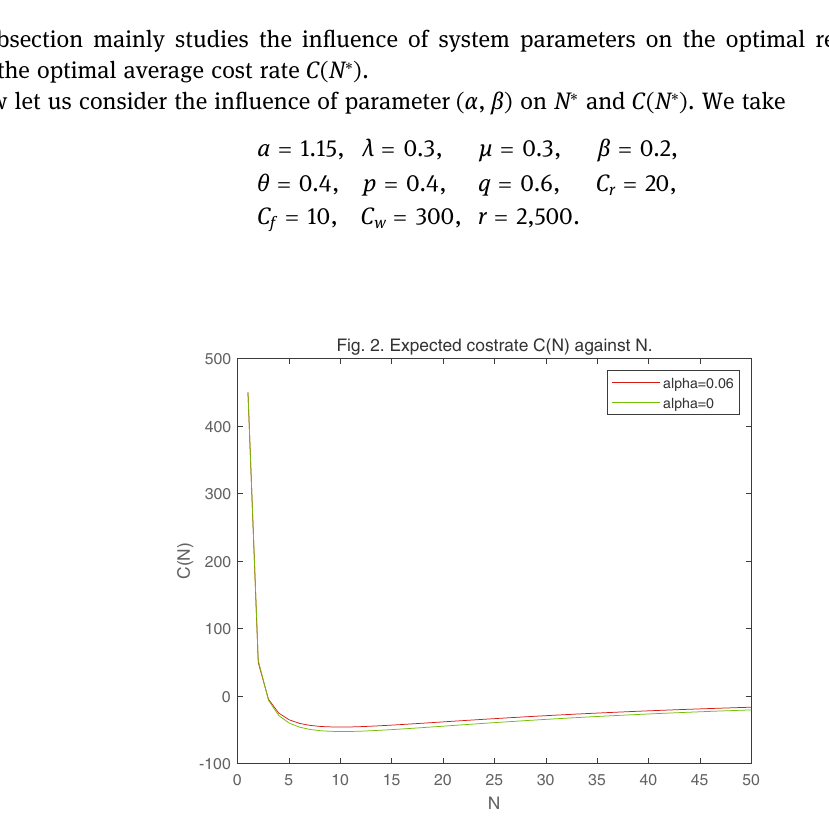
Figure 1: Change trend of ( ) C N with the number of failures N